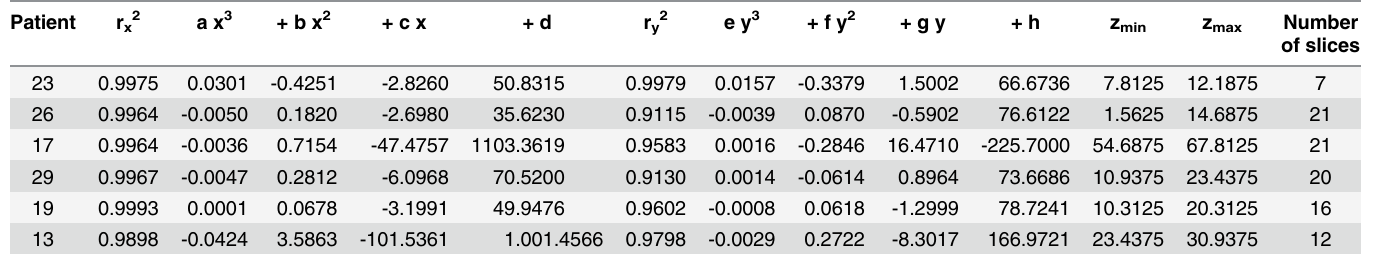
Table 1. Polynomial models for the right NLCs of six subjects selected at